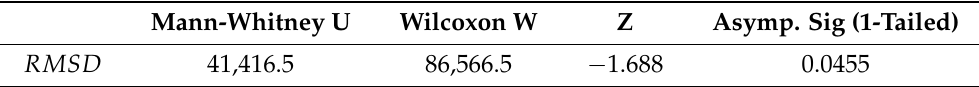
Table 4. Statistical data analysis results by the Mann–Whitney U Test